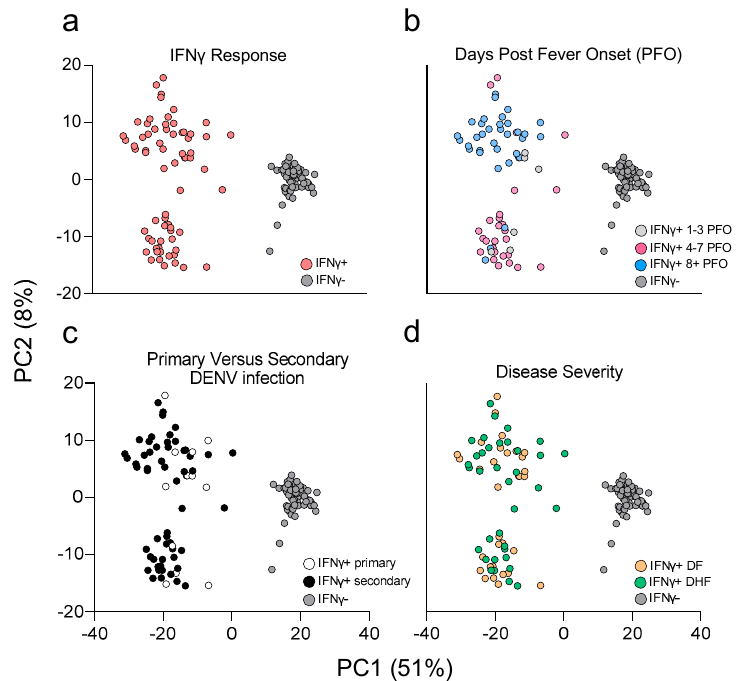
Figure 2. Principal component (PC) analysis of microscaled RNAseq data of DENV-specific IFN- γ + and IFN γ− CD8+ T cells. PC1 shows separation for IFN γ− (grey) and IFN γ + (red) samples ( a ). PC2 shows separation as function of days post fever onset between 4–7 days (magenta) and 8+ (light blue), no clear separation observed for 1–3 days (light grey) ( b ). No clear pattern observed as function of primary (white) or secondary (black) DENV infection ( c ). No separation observed as function of disease severity ( d ); DF are shown in orange and DHF in green. Percentage variance explained is shown for PC1 (51%) and PC2 (8%), respectively.